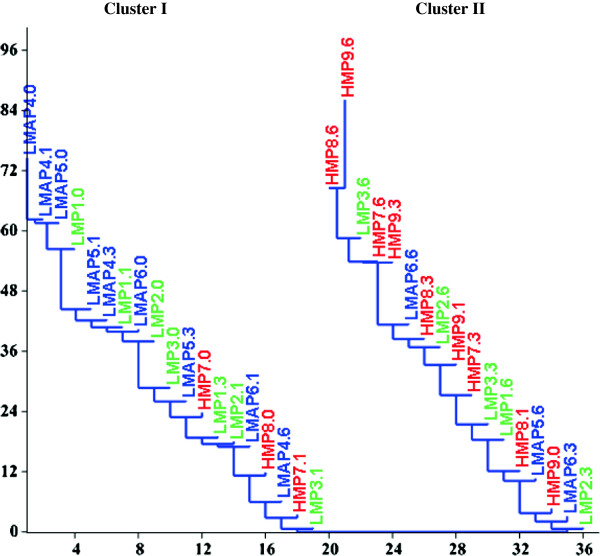
Representation of neighbor-joining cluster analysis of jams based on TMA, TP and FRAP. Legend: LMP1: LMP 1%; LMP2: LMP 0.7%; LMP3: LMP 0.3%; LMAP4: LMAP 1%; LMAP5: LMAP 0.7%; LMAP6: LMAP 0.3%; HMP7: HMP 1%; HMP8: HMP 0.7% and HMP9: HMP 0.3%. In samples labeled as LMP1.0, LMP1.6 and so on, the number after point represents the storage time. Cluster I: LMAP4.0 > LMAP5.0 > LMAP4.1 > LMP1.0 > LMAP5.1 > LMAP6.0 > LMAP4.3 > LMP1.1 > LMP2.0. >LMAP5.3 > LMP3.0 > LMAP6.1 > LMP2.1 > LMP1.3 > LMAP4.6 > LMAP6.3 > HMP7.0 > LMP3.1. Cluster II: LMP2.3 > HMP8.0 > LMAP5.6 > HMP7.1 > LMP3.3 > HMP9.0 > HMP8.1 > LMP1.6 > LMAP6.6>. HMP7.3 > LMP2.6 > HMP8.3 > HMP9.1 > LMP3.6 > HMP9.3 > HMP7.6 > HMP8.6 > HMP9.6.